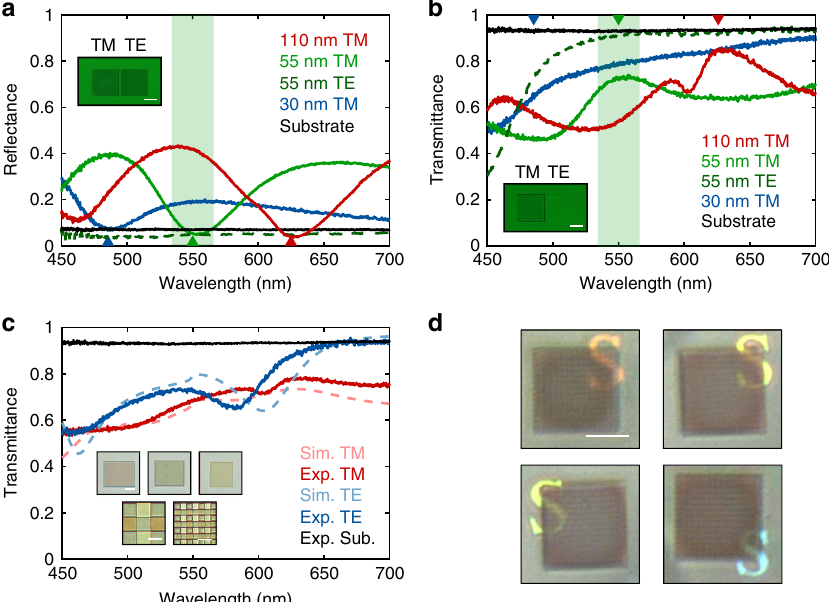
Fig. 2 Transparency of fabricated NW array pixels. a Re fl ectance and b transmittance as a function of wavelength for three different NW array pixels designed for red ( w = 110 nm, p = 310 nm), green ( w = 55 nm, p = 280 nm), and blue ( w = 30 nm, p = 230 nm) light for both polarizations. The inverted triangles indicate the wavelengths at which the NW pixels show zero re fl ectance in the simulations. The re fl ectance and transmittance of the substrate (black) is also included for reference and the re fl ection from the back surface of the sapphire substrate is removed in post data-processing. Insets: a Re fl ection and b transmission optical images for “ green ” pixels for two orthogonal polarizations. The incident light is polarized in the vertical direction and the NWs are aligned in the vertical direction for the left pixel and in the horizontal direction for the right pixel, respectively. A green color fi lter was used. Scale bar: 25 μ m. c Overall white-balanced transmittance of three different NW array pixels as a function of wavelength for both polarizations. Insets: Transmission optical images of 25 μ m size (top), 5 μ m size (bottom left), and 2 μ m size (bottom right) NW array pixels under TM-polarized illumination. Scale bar: 10 μ m (top) and 5 μ m (bottom). d Optical re fl ection images of multiplexed 5- μ m-size NW array pixels under unpolarized white-light top illumination. Different colored letters “ S ” are placed under the pixel array. Scale bar: 25 μ